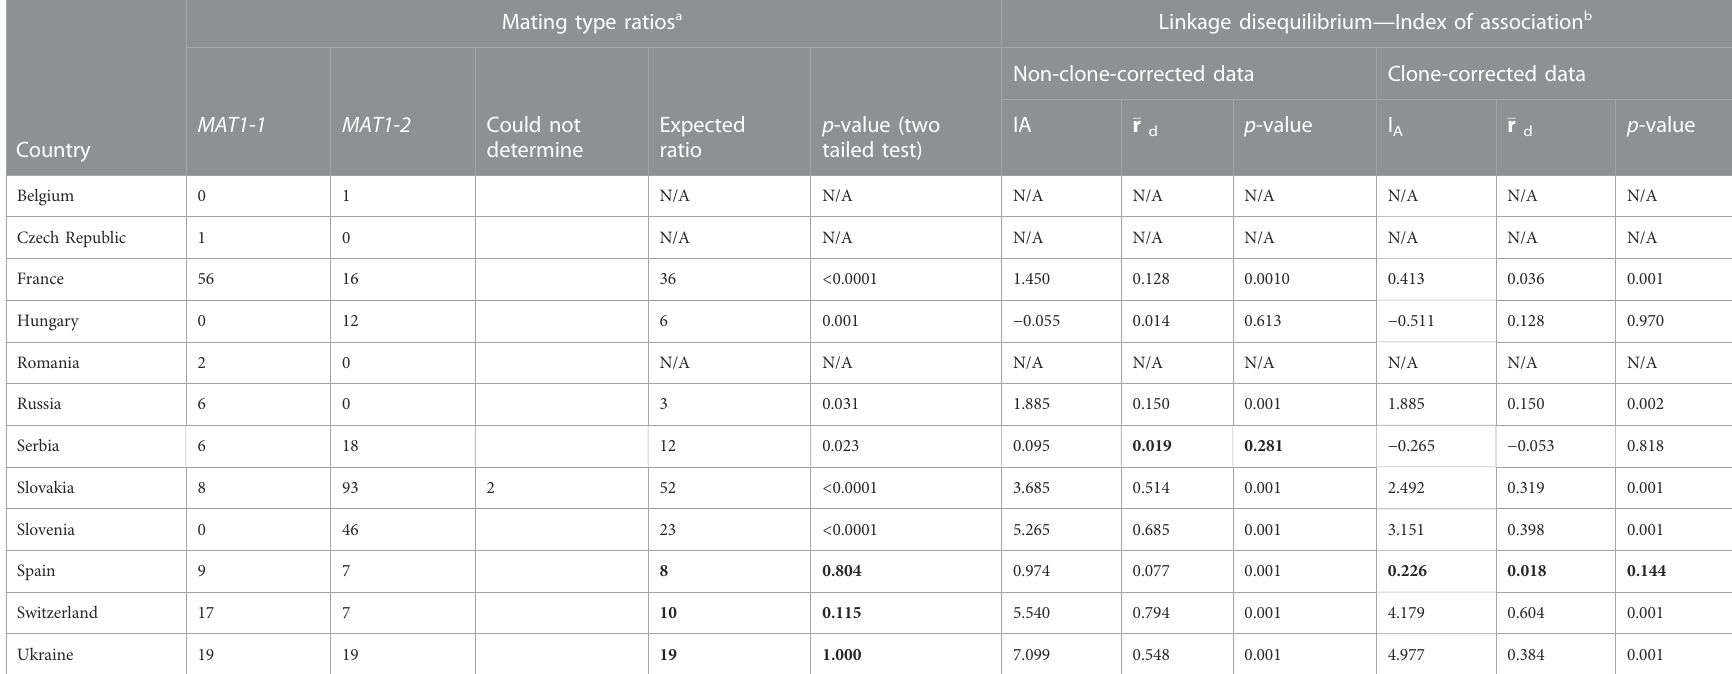
TABLE 3 Mating type ratios and index of association tests for the Dothistroma pini populations collected in Europe.